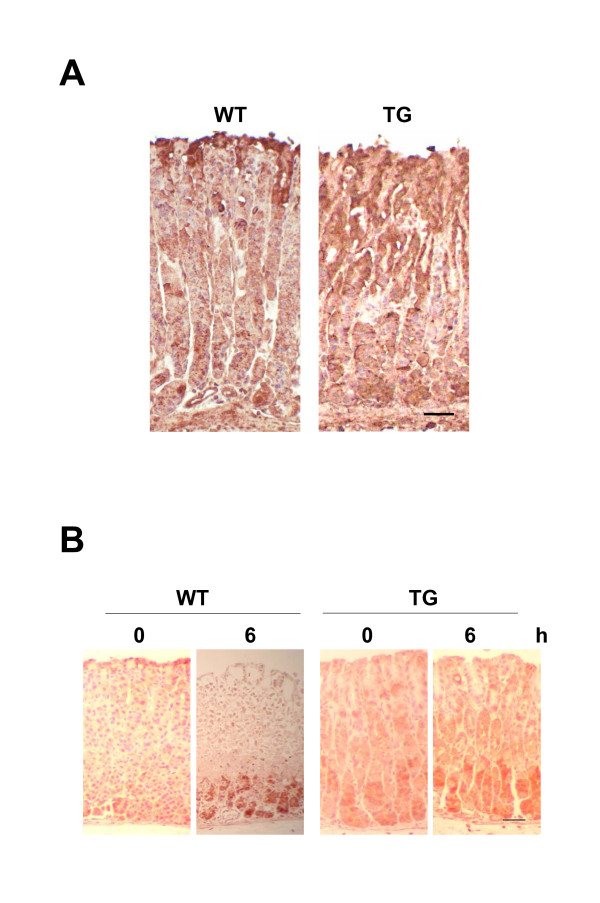
Immunostaining of NO synthases in the gastric mucosa. Scale: 100 μm. (a) nNOS immunostaining. nNOS was visible along the pit region, resulting in its wider distribution along the elongated pit in the TG mucosa. (b) iNOS immunostaining. iNOS was induced in the lower glandular region after ethanol injury in the WT mucosa, whereas it was constitutively expressed in the same region of the TG mucosa irrespective of ethanol injury.